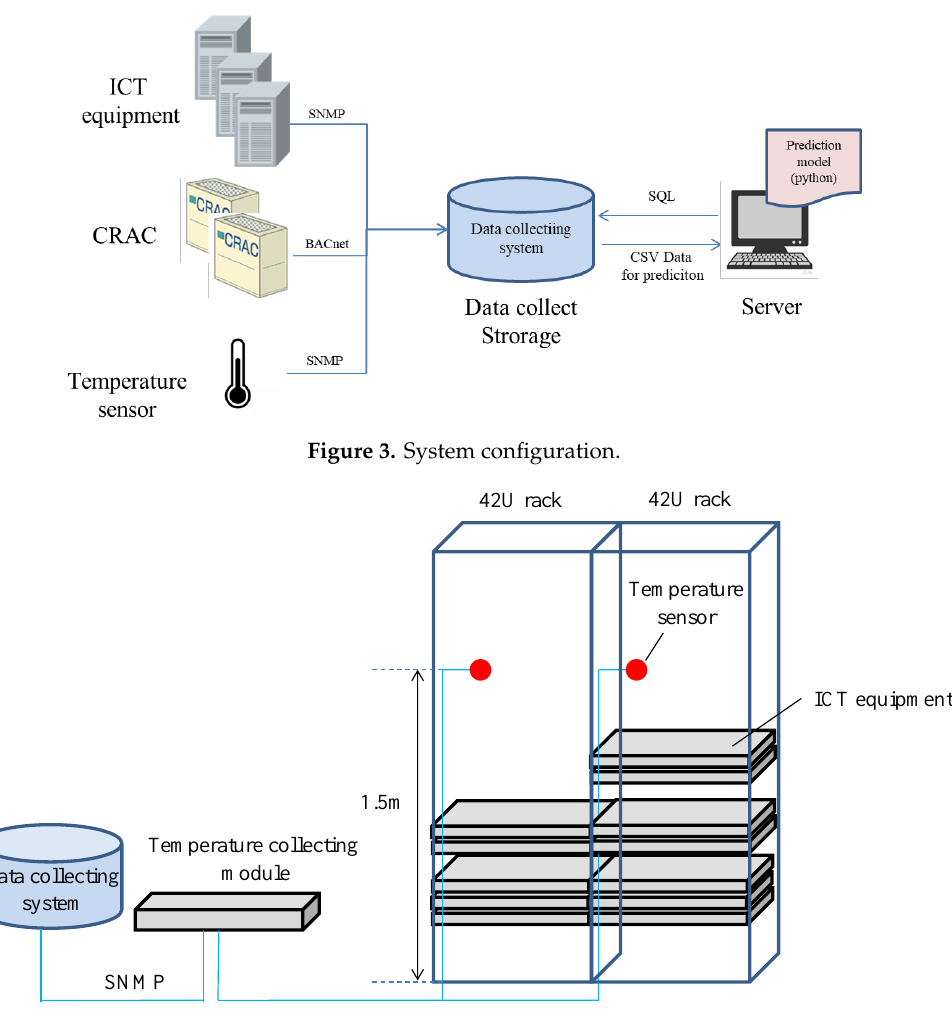
Figure 4. Installation of temperature sensor and way to get data.